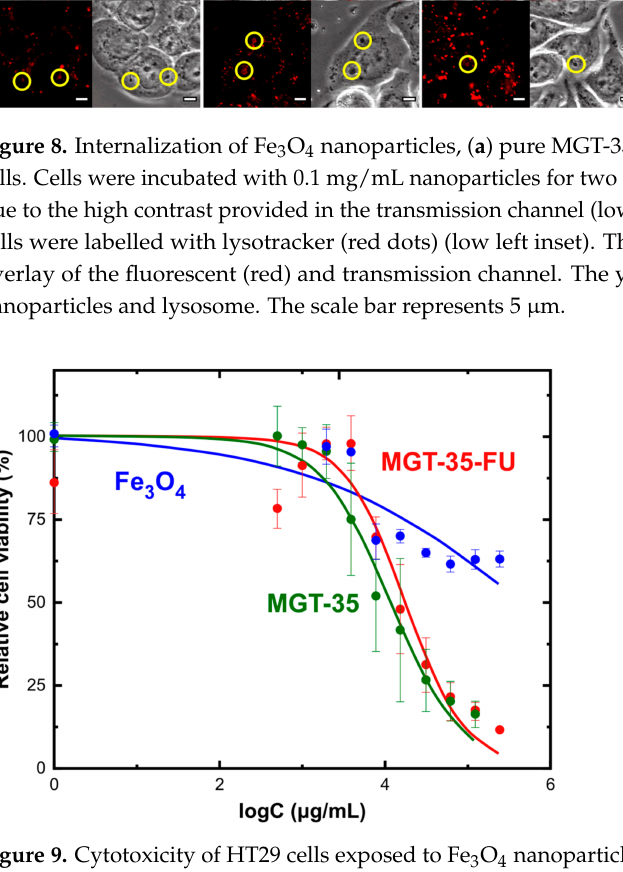
Figure 9. Cytotoxicity of HT29 cells exposed to Fe 3 O 4 nanoparticles (blue line), MGT-35 (green line) and MGT-35-FU (red line). The cell viability was normalized using the highest signal measured and the percentage was plotted against the logarithm of the samples’